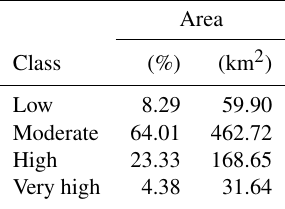
Table 6. Areas of the drinking water